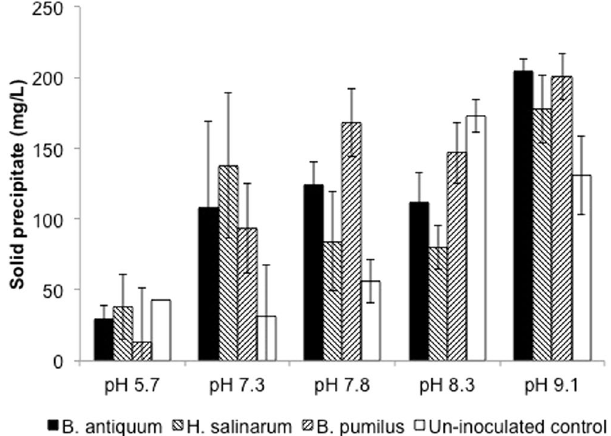
Figure 4. Solid precipitate collected after 6 days of incubation of pure cultures of the selected bacteria in magnesium supplemented sludge dewatering liquors at different initial pH values. Error bars represent standard deviation obtained from triplicate